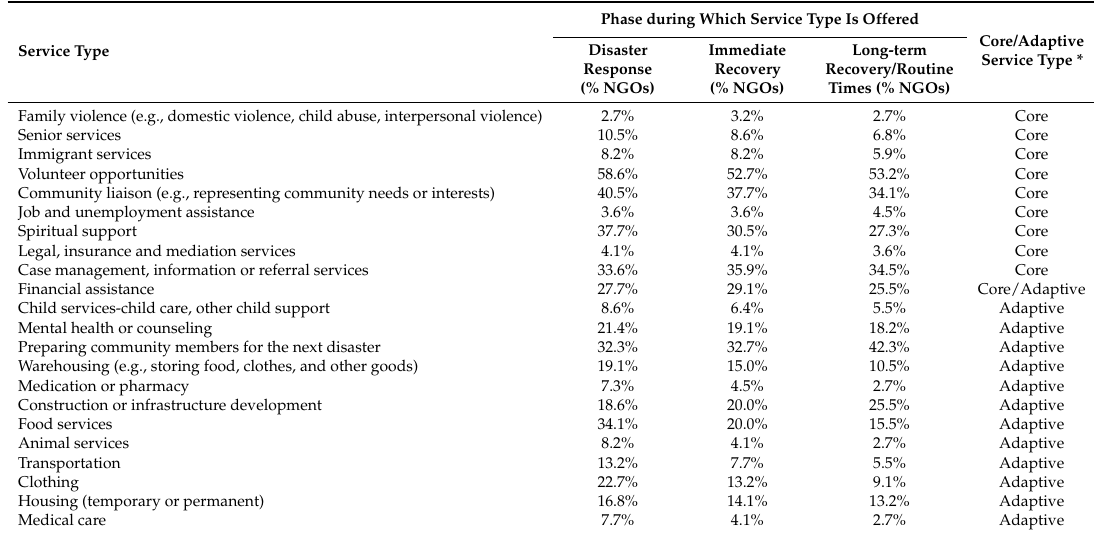
Table 2. NGO core and adaptive service types by disaster phase ( N =